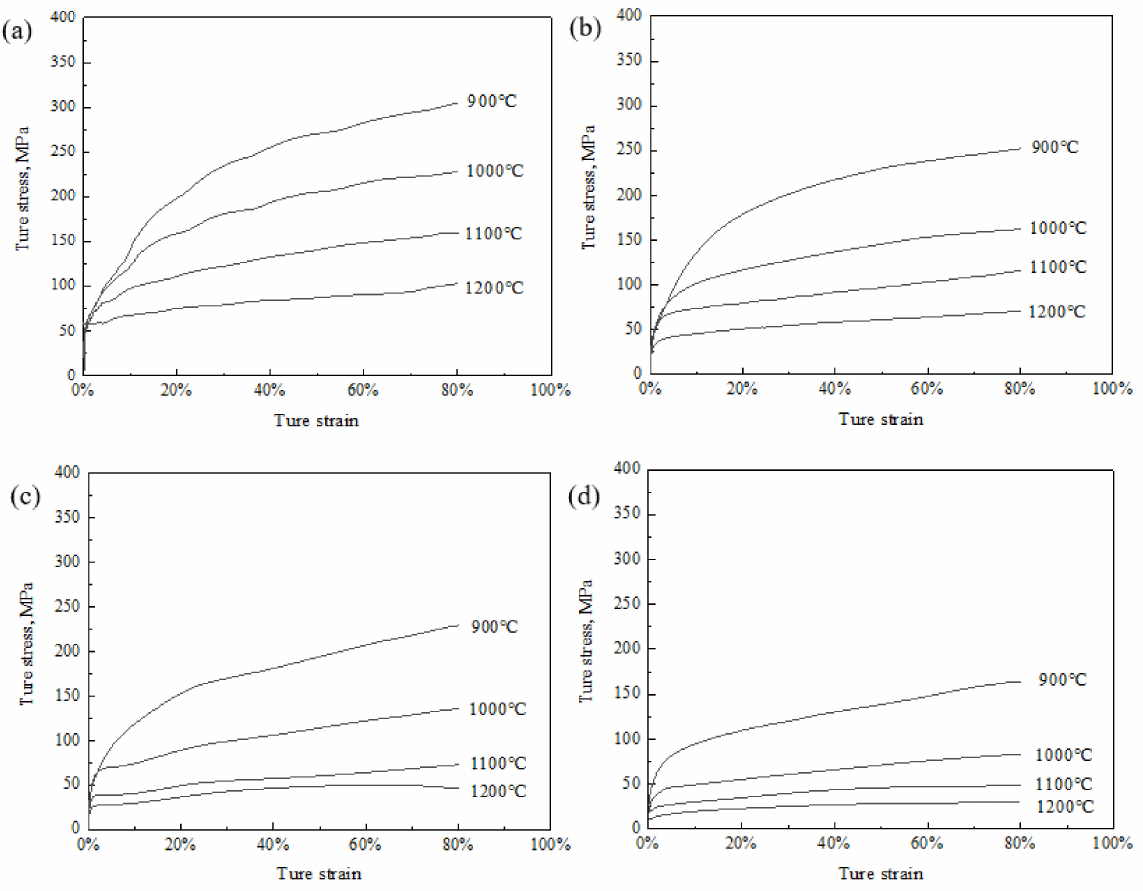
Figure 4. Flow curves of tested steel under different stain rate conditions: ( a ) 10 s − 1 ; ( b ) 1 s − 1 ; ( c ) 0.1 s − 1 ; ( d ) 0.01 s − 1